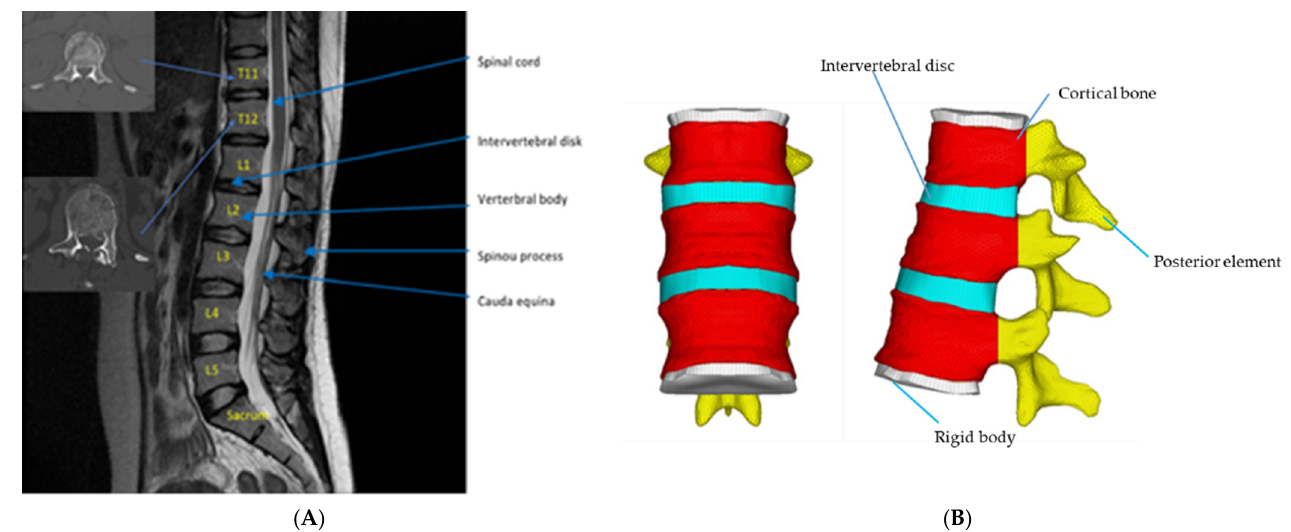
Figure 2. ( A ) CT image of the human vertebrae ( B ) T11-L1 Finite element model.